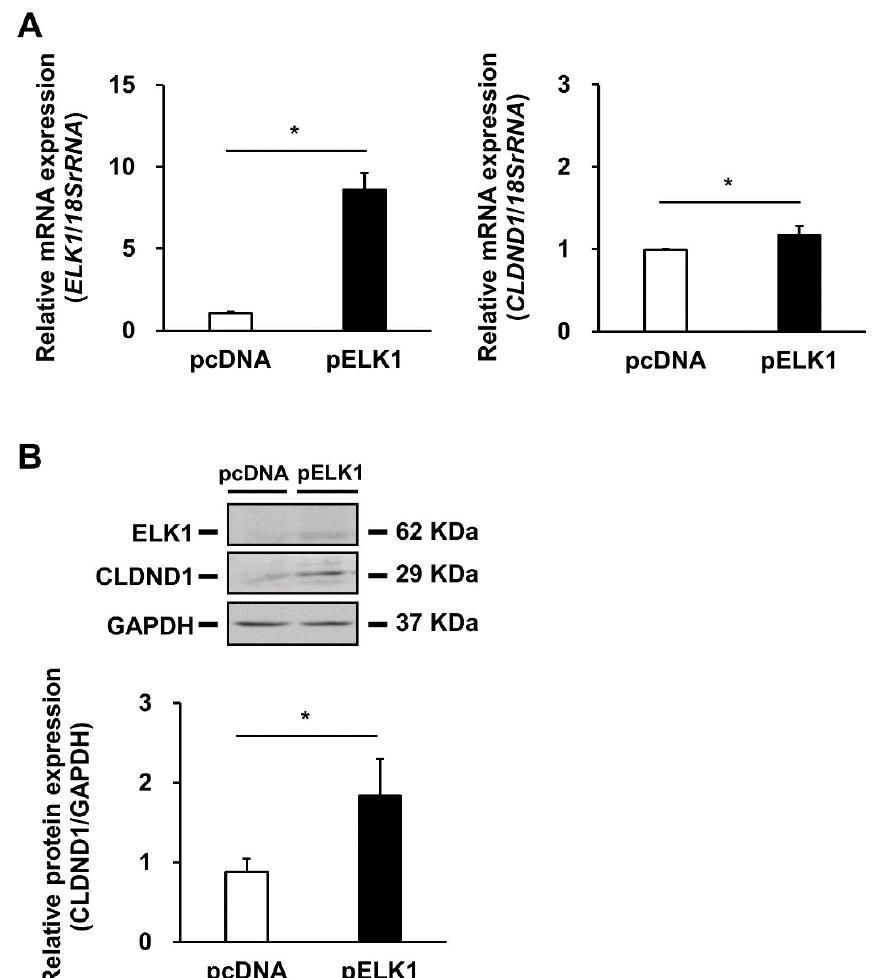
Figure 3. Effect of ELK1 overexpression on CLDND1 expression levels. ( A ) HBECs were transfected with an empty (pcDNA) or ELK1-expressing (pELK1) vector and incubated for 72 h. mRNA levels of ELK1 and CLDND1 were determined using qRT-PCR. 18S rRNA was used for internal correction. ( B ) HBECs were transfected with the pcDNA or pELK1 vector and incubated for 72 h. The protein levels of ELK1 and CLDND1 were determined using western blotting with the anti-FLAG and anti- CLDND1 antibodies, respectively. GAPDH was used for internal correction. Results are expressed as means ± SE, n = 3, * p < 0.05.